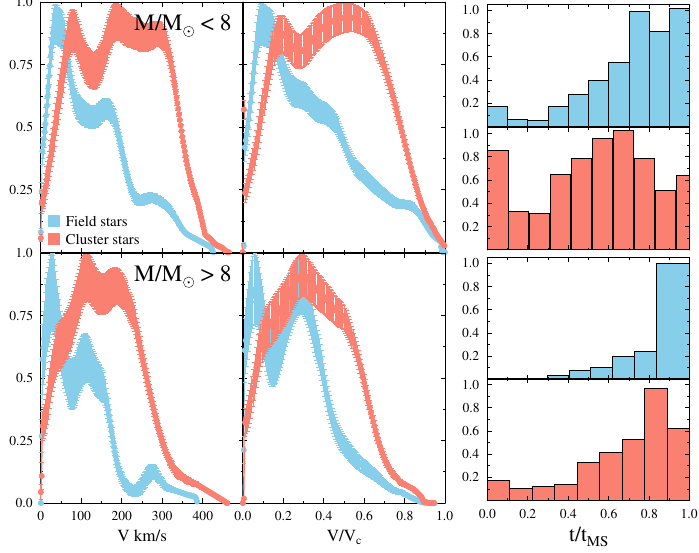
Figure 28. Two left blocks: smoothed and normalized distributions of the true V and ratios V / V c of the B-type star rotational velocities with masses M < 8 M (cid:12) (upper row) and with masses M > 8 M (cid:12) (lower row). Right blocks: histograms of fractional age distributions t / t MS of stars in the respective left blocks.